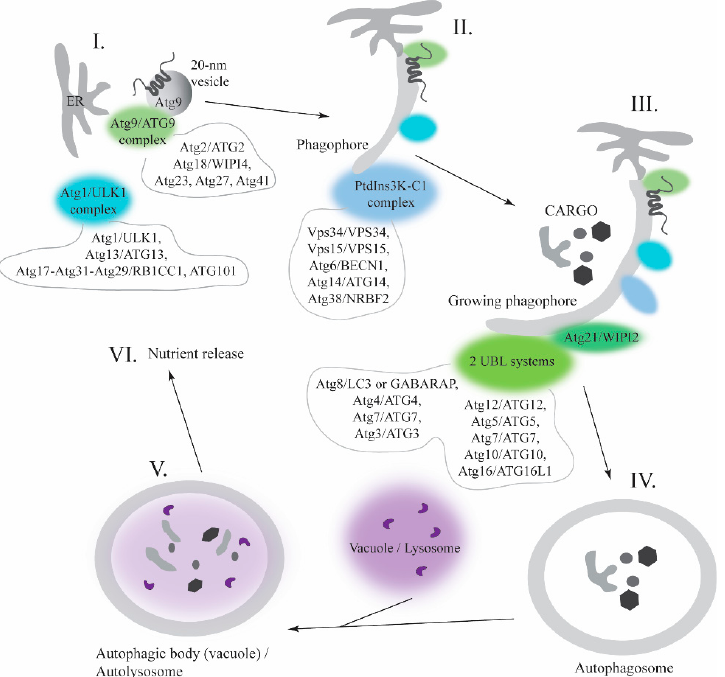
Figure 1. Schematic representation of the autophagy pathway. ( I ) Induction: Atg9/ATG9 vesicles, components of the Atg9 (yeast)/ATG9 (higher eukaryotes) complex, the endoplasmic reticulum (ER), and the Atg1/ULK1 complex gather together. ( II ) Nucleation: The PtdIns3K-CI complex enriches the phagophore phospholipid membrane with PtdIns3P, which leads to the recruitment of additional components of the autophagy machinery. ( III ) Expansion: Recruitment of the two ubiquitin-like (UBL) protein systems promotes conjugation of Atg8/LC3 or GABARAP to phosphatidylethanolamine (PE), and ensures the phagophore expansion. ( IV ) Maturation: Closure of the phagophore engulfs the cargo and forms the double-membrane autophagosome. Autophagy components leave the outer membrane and the mature autophagosome fuses with the vacuole/lysosome. ( V ) Breakdown: A large size of the vacuole leads to the release of the inner autophagic vesicle, the autophagic body, into the vacuolar lumen. In higher eukaryotes, a small lysosome fused with the autophagosome forms the autolysosome. Resident hydrolases and lipases degrade the cargo. ( VI ) Release: Resulting macromolecules are released into the cytosol for reuse of